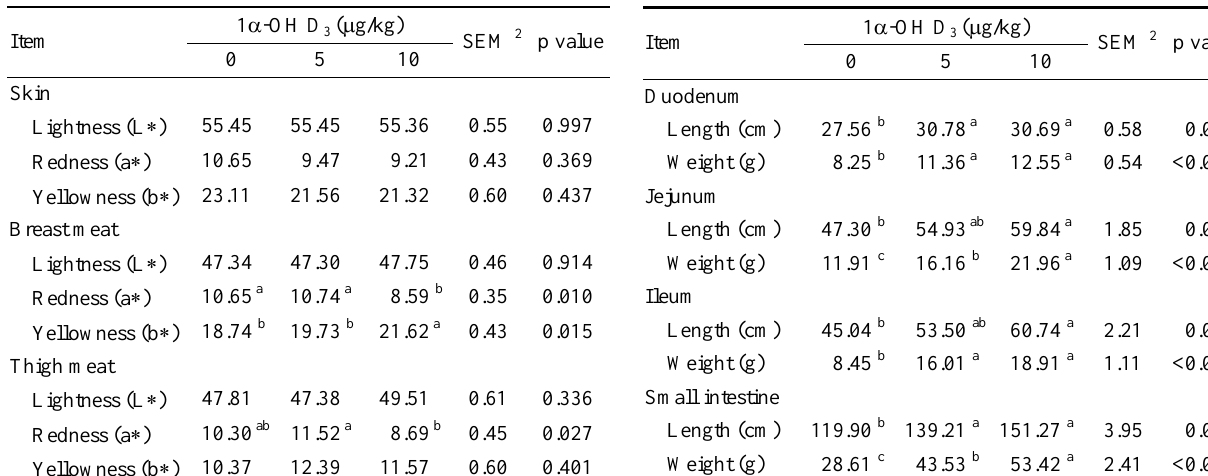
Table 3. Effect of 1  -OH D 3 on skin, breast meat, and thigh meat color of 21- to 42-d-old broilers 1